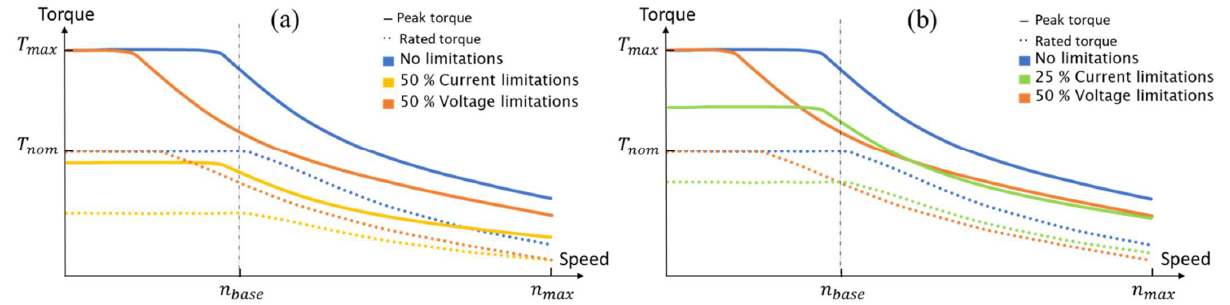
Figure 16. Effects of voltage and current limitations on motor performance. ( a ) Current and voltage limitations by 50%, ( b ) Current limitations by 25%.